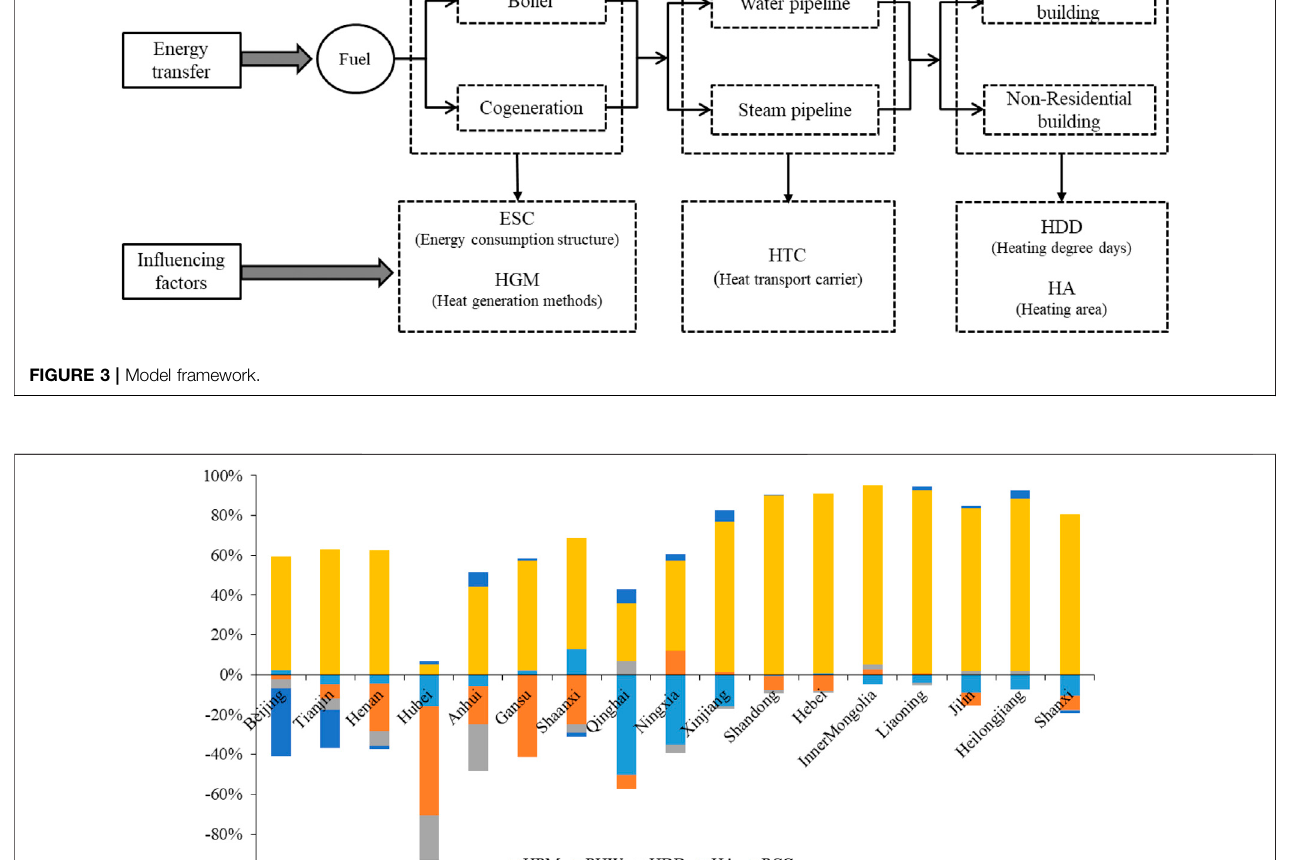
FIGURE 4 | The contribution of each factor to the energy consumption of each province ’ s central heating sector.